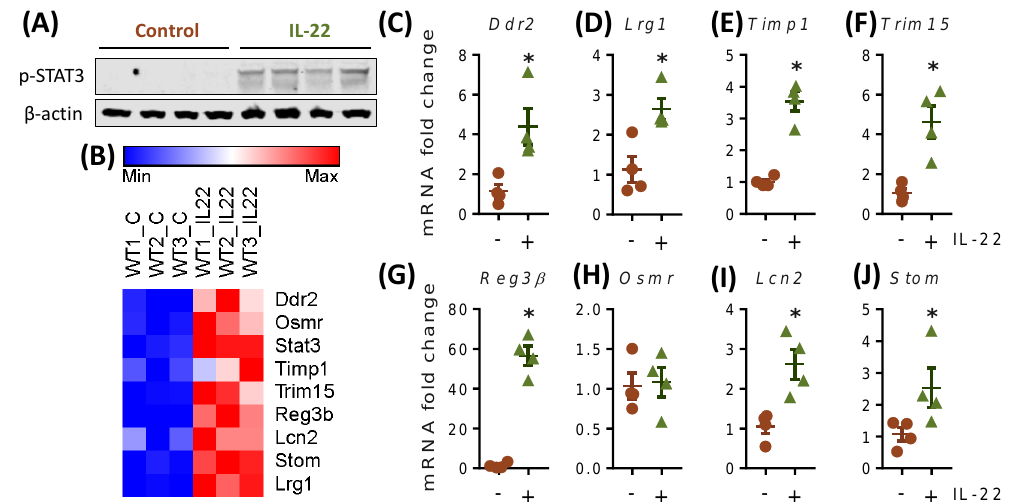
Figure 6. IL-22-mediated transcriptional changes in primary epithelial cells. Murine intestinal epithelial cells (mIECs) were treated with 100 ng/mL of mIL-22 for 4 h and ( A ) activation of STAT3 was assessed using Western blotting. RNA-Seq was conducted and ( B ) gene ontology analyses showed differential expression of antimicrobial peptides, glucose transporter, and proliferation-migration associated genes with IL-22. qRT-PCR was performed to validate the expression of ( C ) Ddr2, ( D ) Lrg1, ( E ) Timp1, ( F ) Trim15, ( G ) Reg3β, ( H ) Osmr, ( I ) Lcn2, and ( J ) glucose transporter Stom. Data are presented as mean ± SEM with individual primary cultures from different mice ( n = 4). * p < 0.05 (nonparametric Man-Whitney t -test).